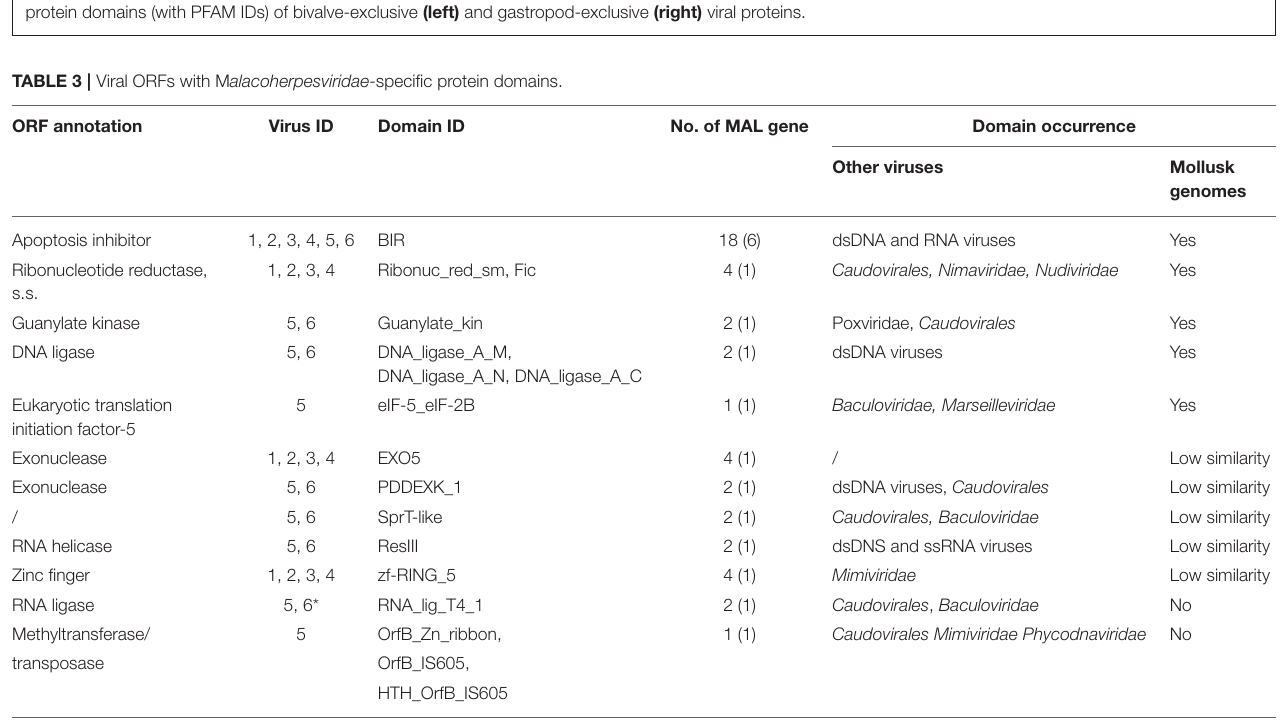
FIGURE 3 | Venn diagram of the protein domains detected in bivalve Malacoherpesviridae , gastropod M alacoherpesviridae, or other Herpesvirales . Organization of protein domains (with PFAM IDs) of bivalve-exclusive (left) and gastropod-exclusive (right) viral proteins.